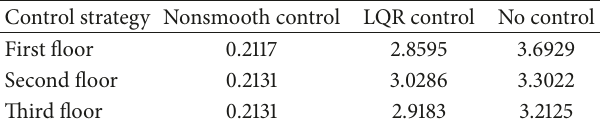
Figure 2: Acceleration response of example 1. Table 1: Maximum displacement of each layer for example 1 (mm).